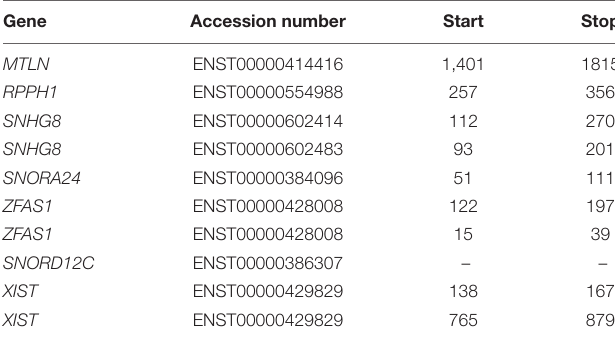
TABLE 1 | List of RNAs examined with the corresponding accession number and transcript coordinates of the ORFs in order of appearance. Gene